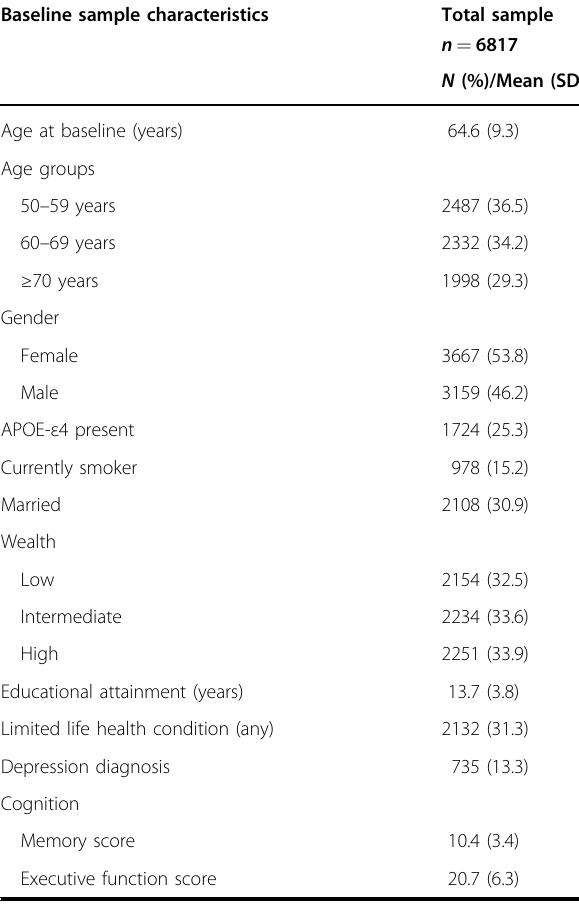
Table 1 Sample characteristics at